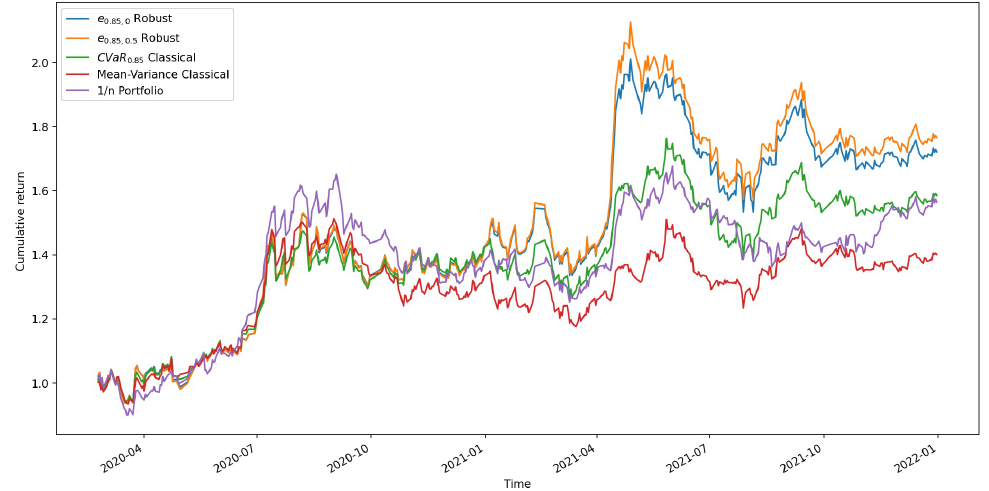
Figure 2. Cumulative returns of optimal portfolio strategies under different